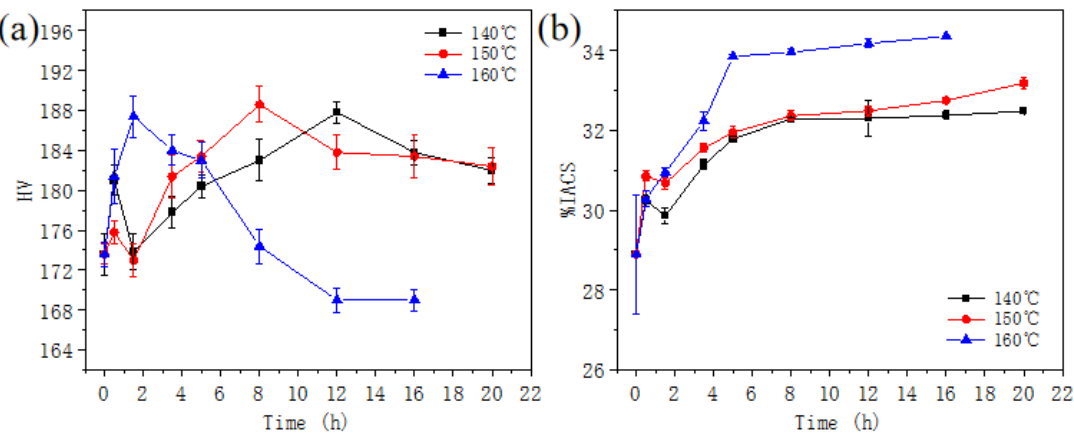
Figure 4. The Vickers hardness ( a ) and electrical conductivity ( b ) Evolution of 7B04-P al alloy during artificial aging at different temperatures.